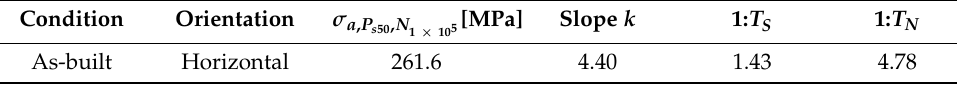
Figure 5. Experimental fatigue test results. Table 4. Evaluated fatigue test